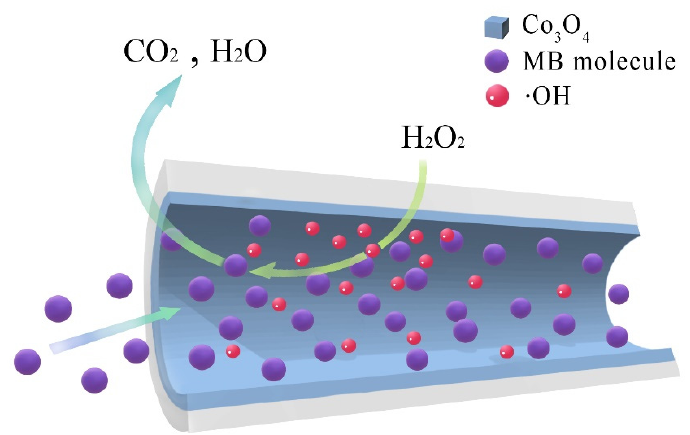
Figure 12. Schematic diagram of the MB adsorbed and degraded by the mesoporous Co–SiO 2 catalyst.